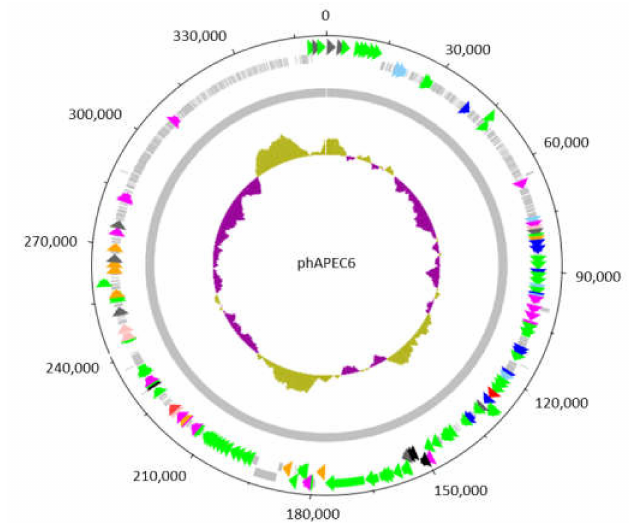
Figure 2. Circular representation of the genome of the giant Escherichia phage vB_EcoM_PhAPEC6. The inner circle represents a GC plot. The 551 identified coding sequences (CDS) are depicted by arrows or boxes if a function could be predicted or not, respectively. The 62 CDS in green, scattered along the genome, are structural proteins detected in the mature virion by mass spectrometry. The CDS indicated in light blue are exonucleases; dark blue corresponds to DNA-associated proteins such as DNA polymerases, topoisomerases, helicases and ssDNA-binding proteins; orange to proteases and dark grey to chromosome condensation domains. CDS in purple and red are involved in general metabolism and host lysis,